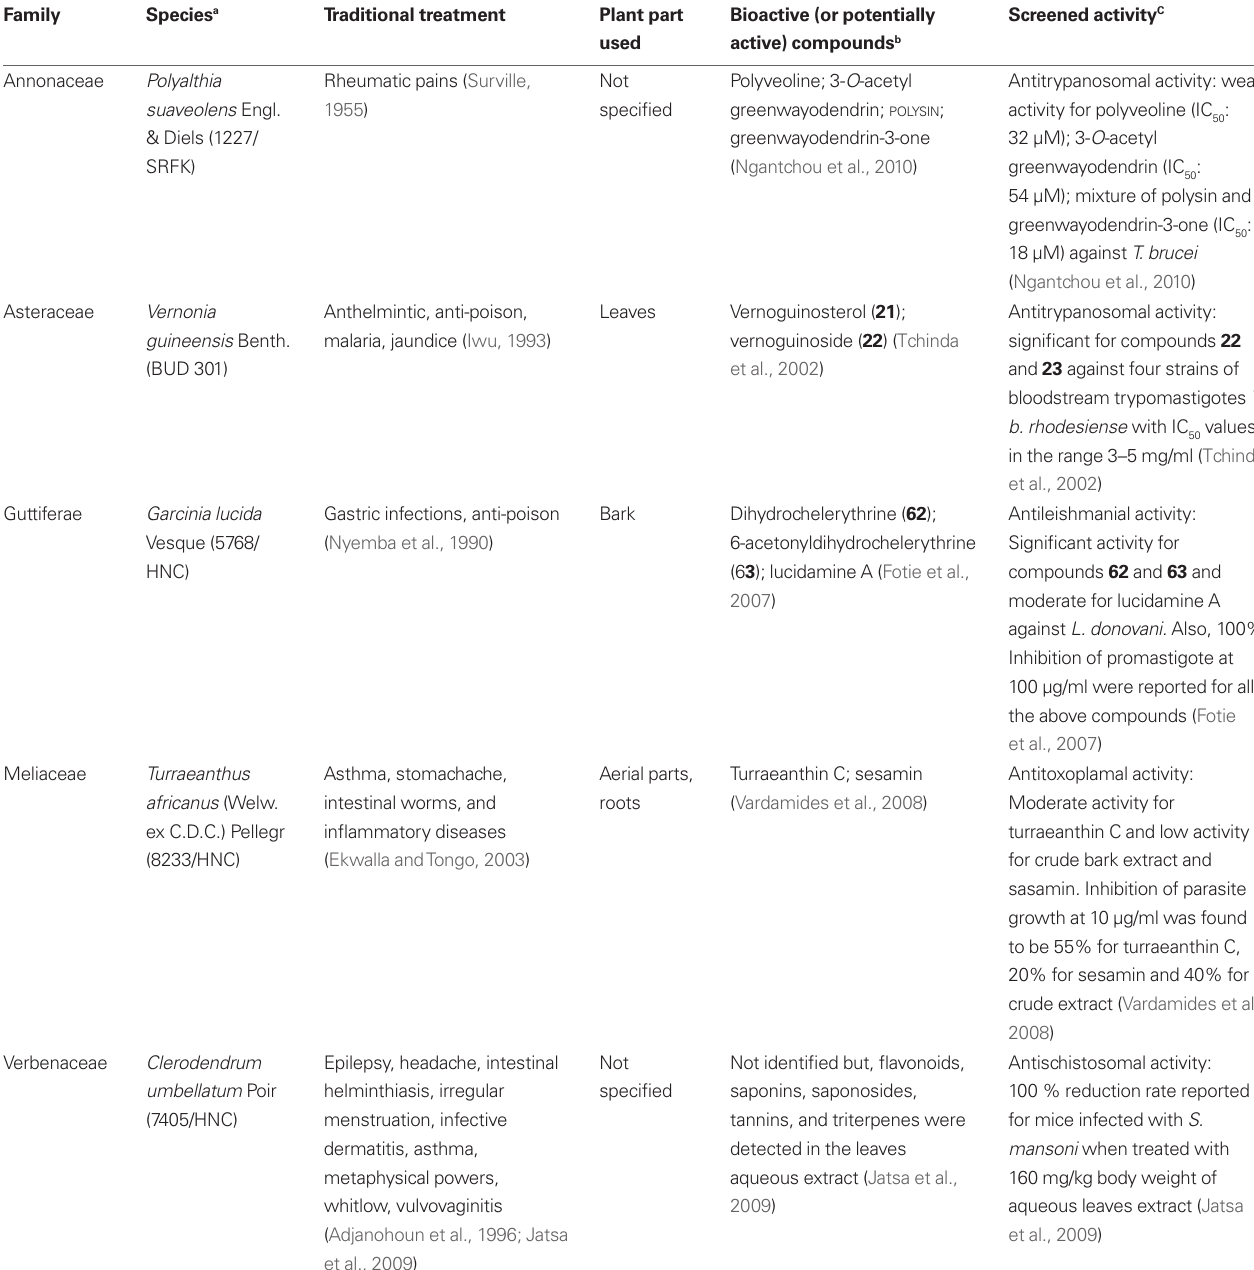
Table 3 | Plants used in Cameroon to treat some parasitic infections with evidence of their